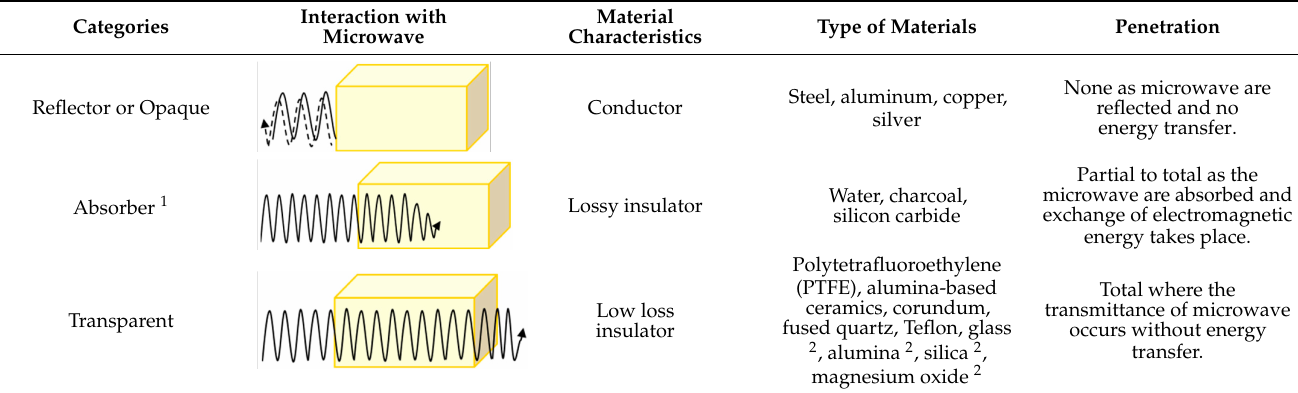
Table 1. The properties of materials interacting with microwaves